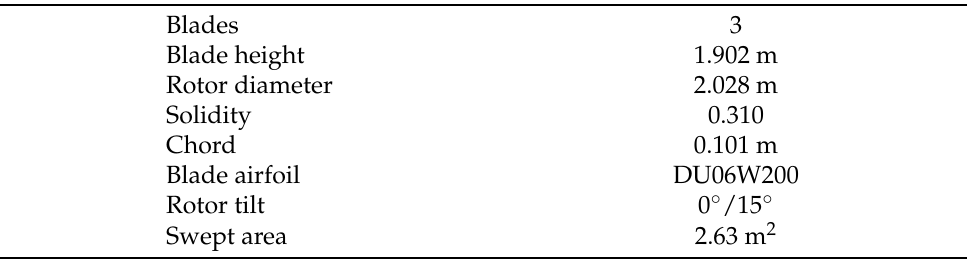
Table 3. DeepWind rotor geometric